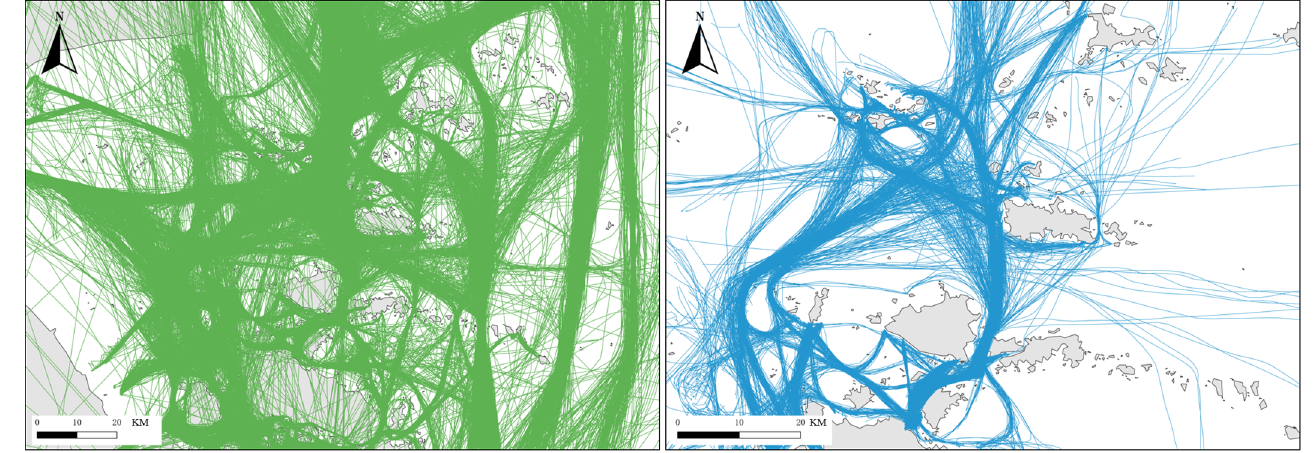
Figure 4. Diagram before and after track data preprocessing.